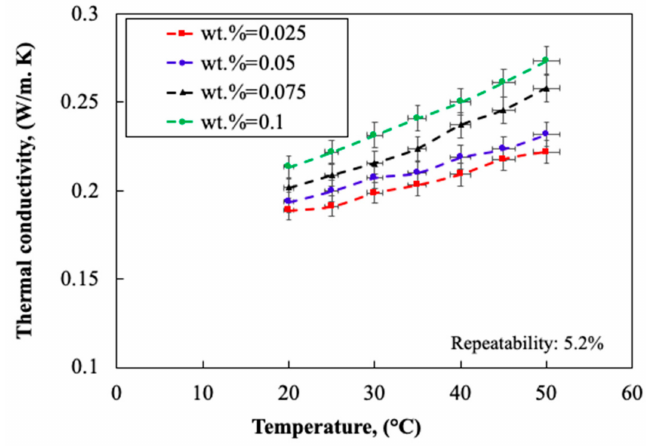
Figure 7. Variation of the thermal conductivity of the prepared nanofluids on temperature for various mass fractions of CNPs in acetone.